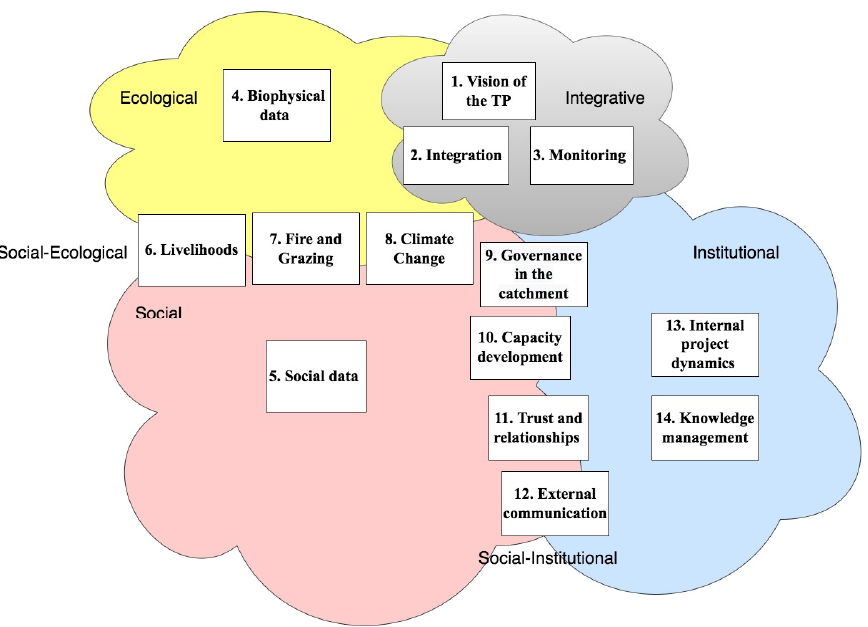
Figure 3. Key issue constellation that shows the fourteen themed key issues gathered from engagement with participants of the Tsitsa Project between 2019 and 2021. The key issues have been categorized as integrative (1, 2, 3), biophysical or ecological (4), social (5), social-ecological (6, 7, 8), social-institutional (9, 10, 11, 12) or institutional (13, 14) domains.